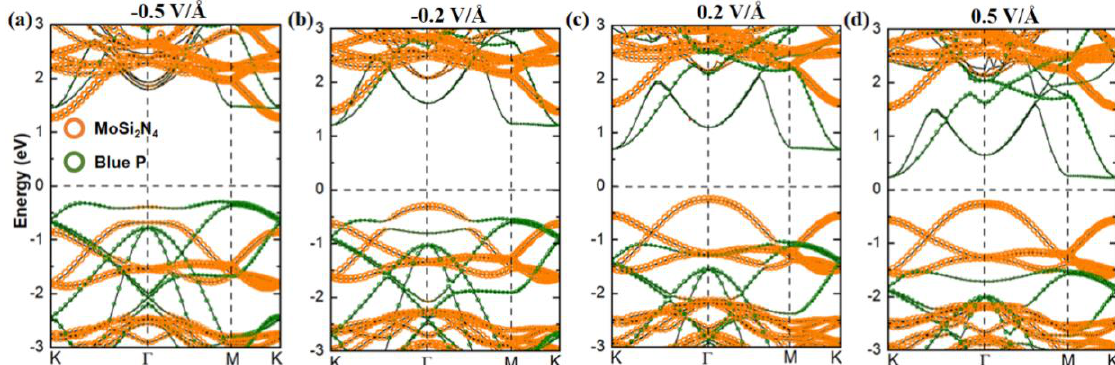
Figure 6. ( a ) Band alignment and ( b ) bandgap together with band offset as a function of E -field in the Blue P/MoSi 2 N 4 vdWH.